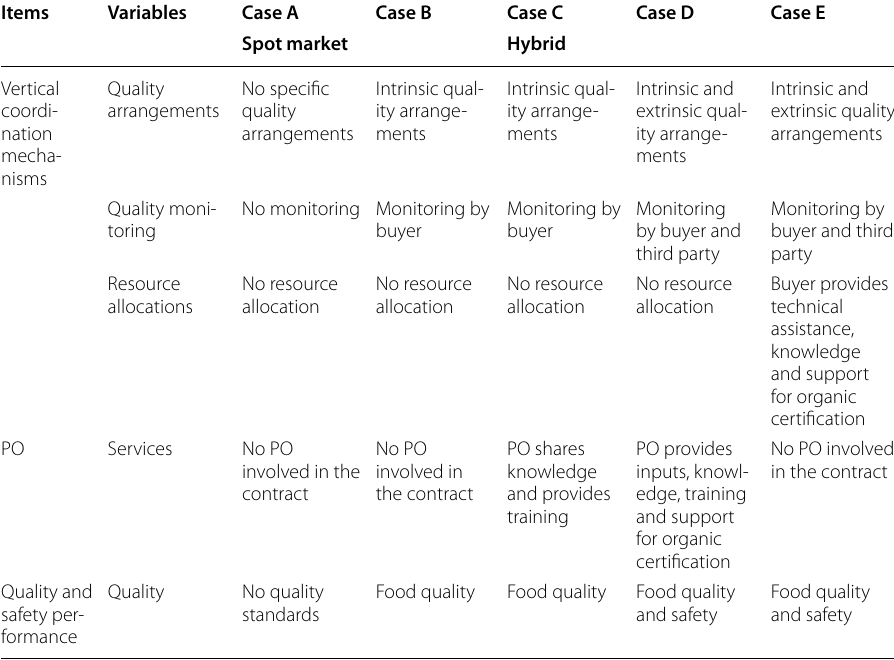
Table 4 Overview of VC mechanisms and POs in the five value chain cases